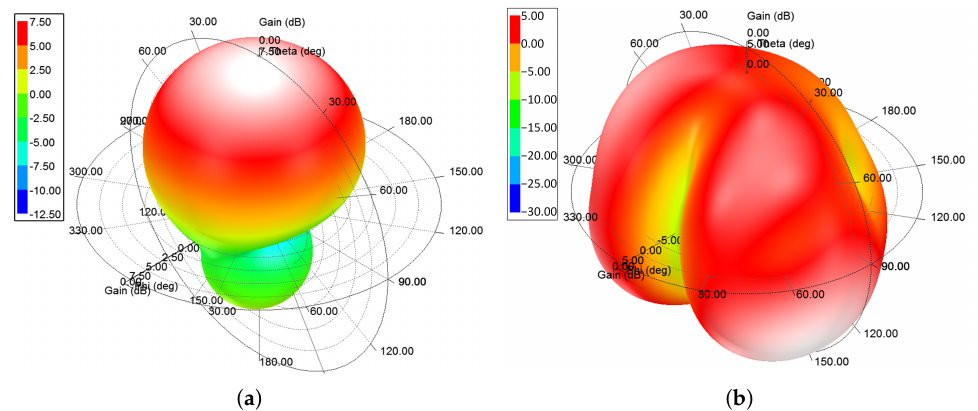
Figure 10. 3D pattern of the antenna gain (realized gain) at ( a ) 26.4 GHz and ( b ) 38.5 GHz (color scale in dB).